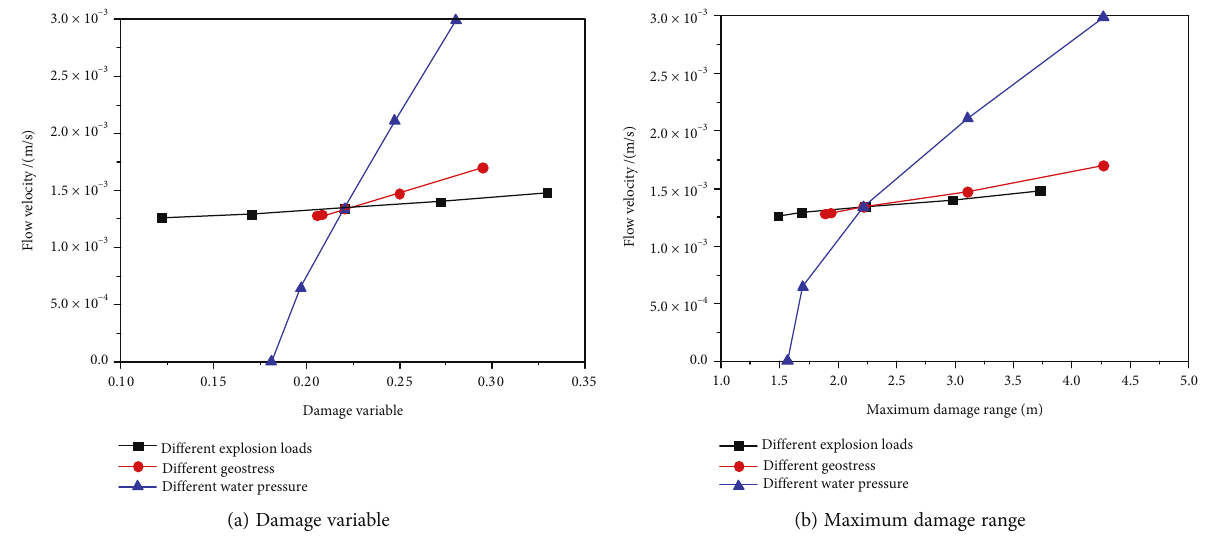
Figure 18: Relation curve between velocity and damage of measuring point